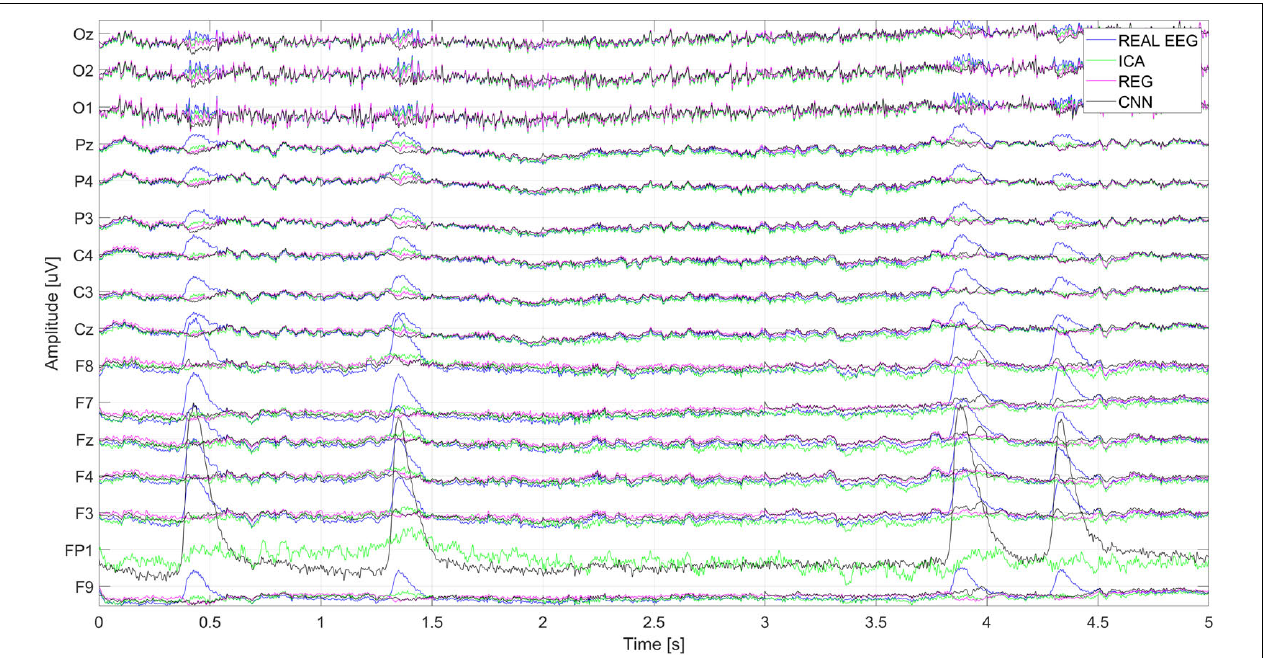
FIGURE 19 | An example of the spectrum of the signal from the Cz electrode.